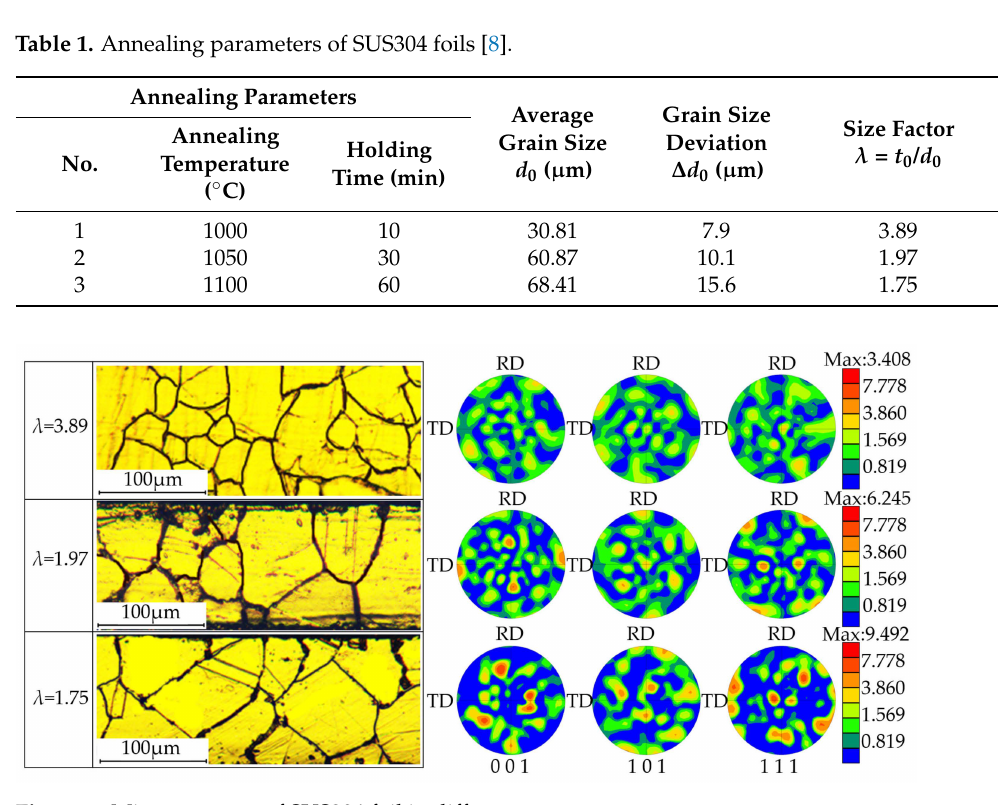
Figure 1. Microstructure of SUS304 foil in different